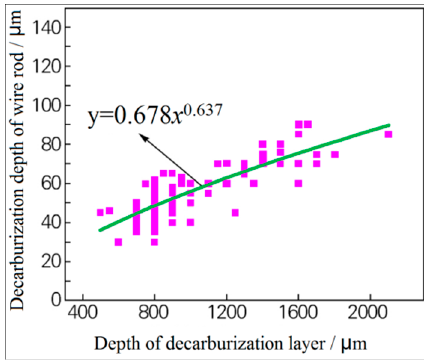
Figure 5. Decarburization of the wire rod before and after the optimization of the heating process: ( a ) wire rod rolled from billet 1 using the conventional process and ( b ) wire rod rolled from billet 2 using the optimized process. Reprinted with permission from ref. [10]. Figure 4. Relationship between the thickness of the original decarburized layer of the billet and the thickness of the wire rod. Reprinted with permission from ref. [10].